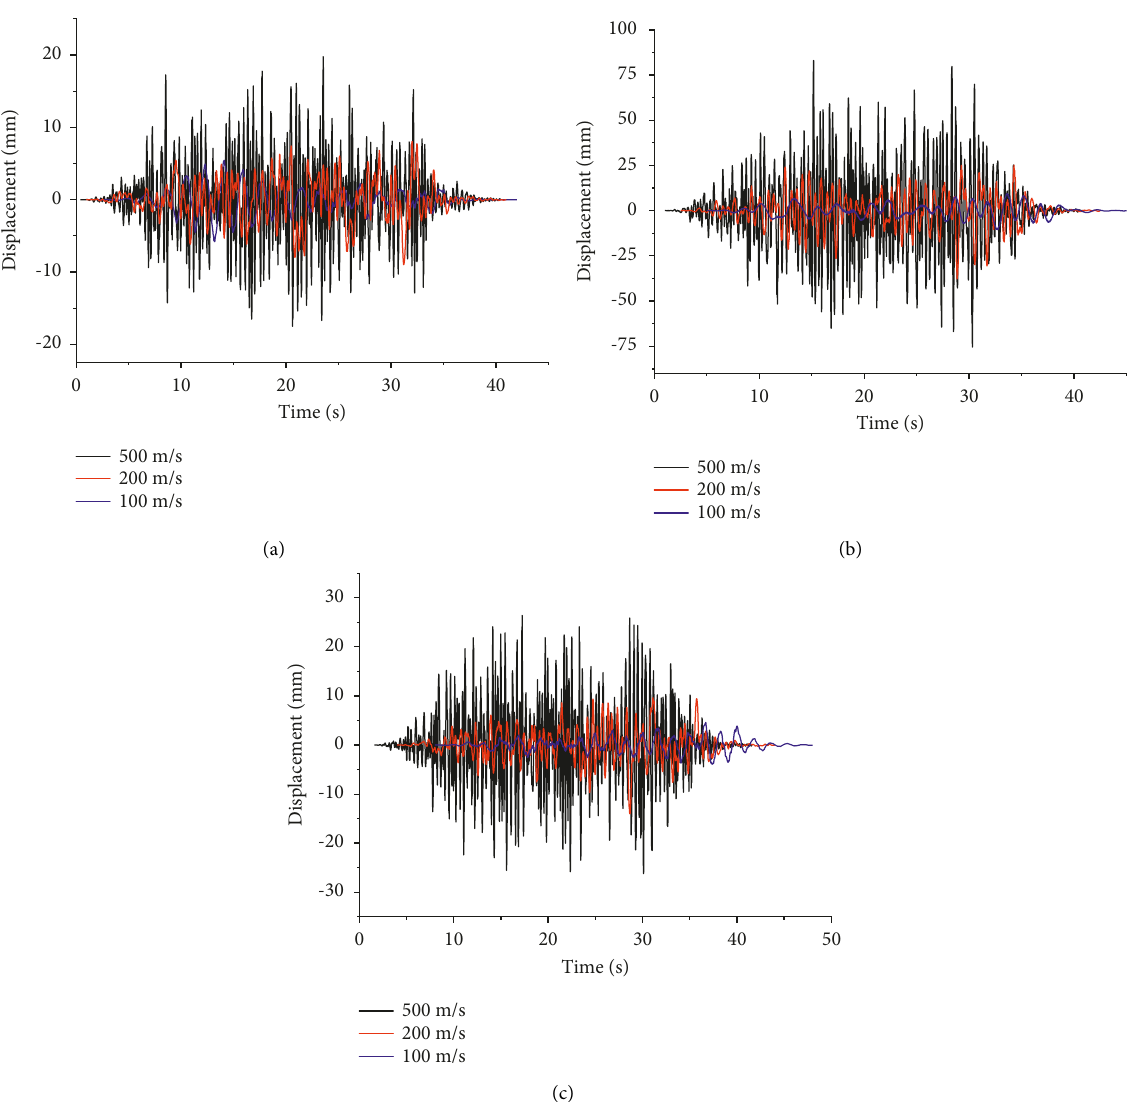
Figure 11: Time course curve of transverse vibration displacement of the pipeline under different wave velocity conditions. (a) At 200m (normal). (b) At 500m (vacant). (c) At 800m (polymer grouting